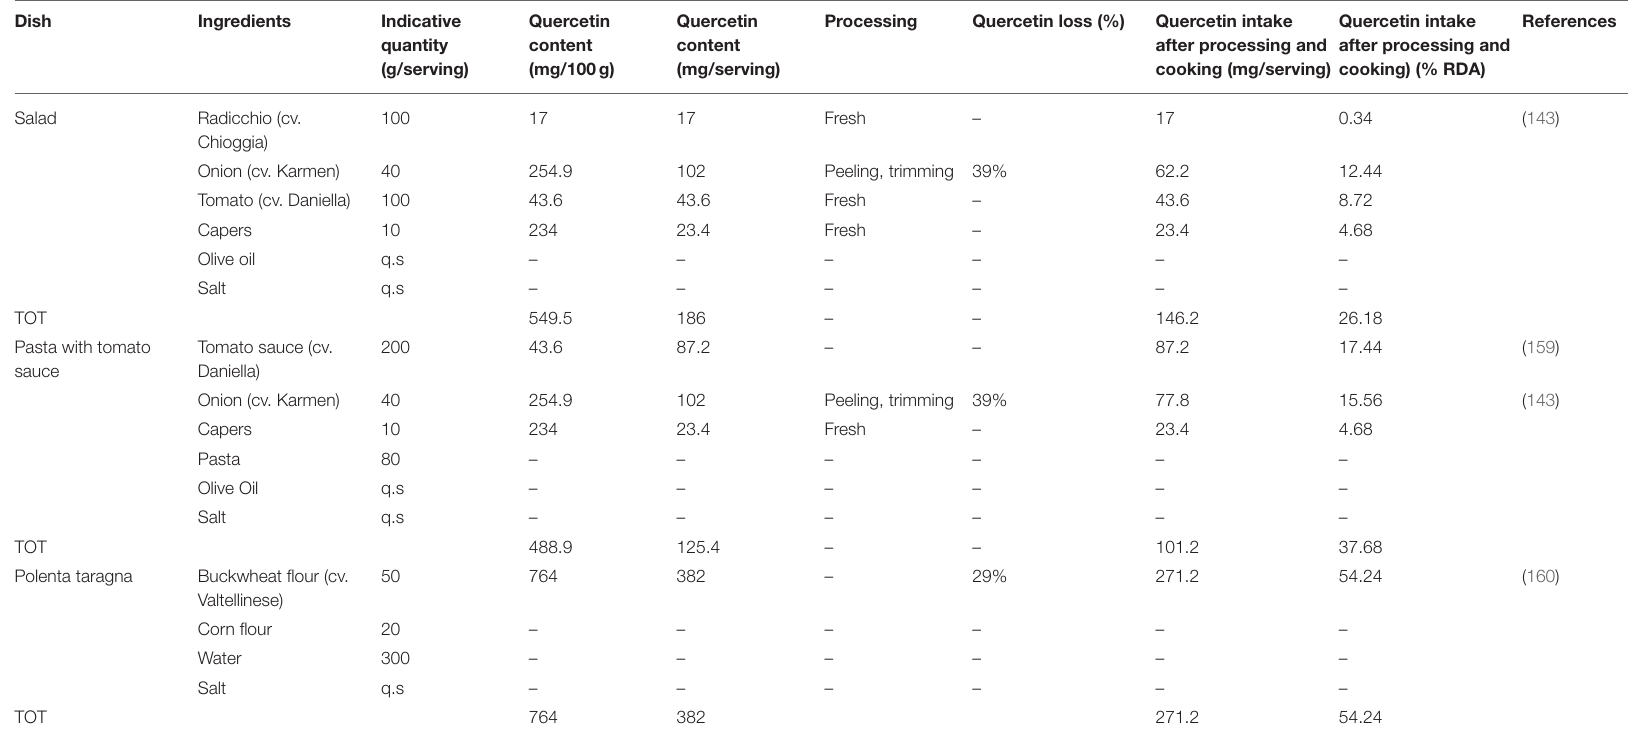
TABLE 2 | Dishes rich in